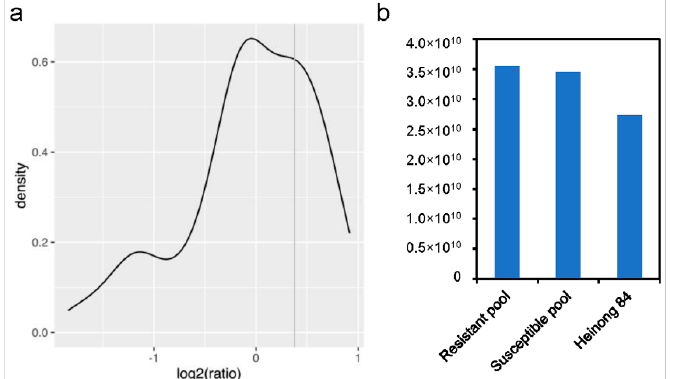
Figure 2. Characterization of the resistant and susceptible populations. ( a ) Distribution of the OD 450 values of the resistant pool. ( b ) Bar chart showing the number of bases with quality higher than 30 of the resistant pool, susceptible pool, and Heinong 84 from the NGS.